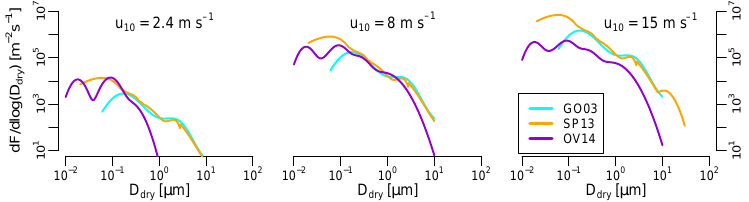
Figure 2. Comparison of the source functions and their wind speed dependence. The largest size mode of OV14 is deactivated for Re Hw ≤ 2 × 10 5 , and all modes are deactivated for Re Hw ≤ 10 5 (see Eq. B7 for the definition of Re Hw ). In SP13, a spume-droplet-generated mode represented by SM93 is activated for u 10 ≥ 9ms − 1 . The parameters used were as follows: SST = 283K, SAL = 35‰, C D = 2 . 15 × 10 − 3